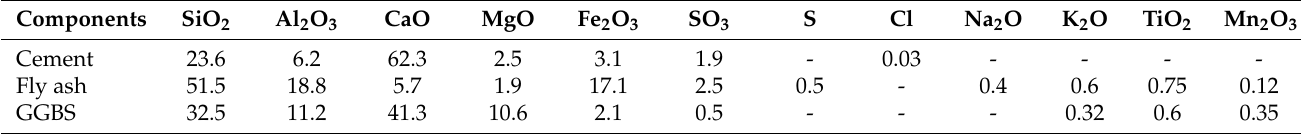
Figure 2. Storage of cement, fly ash, and GGBS in silos. Table 1. Chemical composition of the used materials (expressed in %).